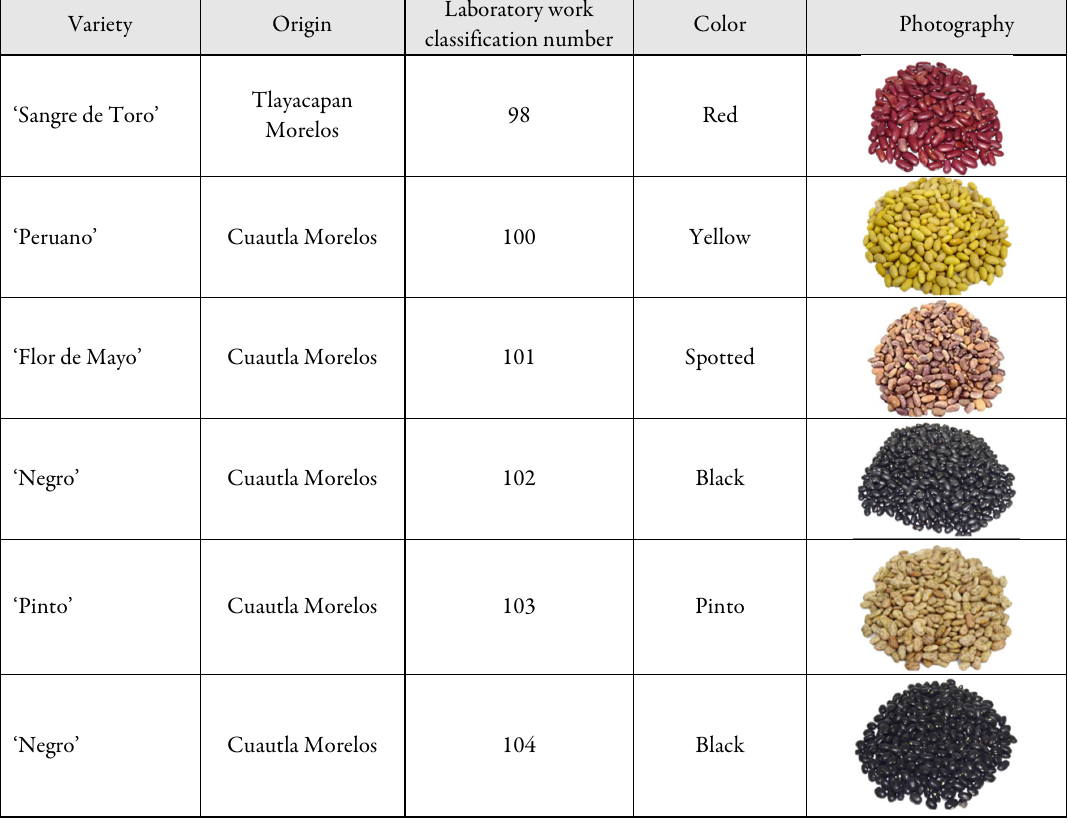
Table 1. Bean varieties grown in Morelos State, Mexico used in the study